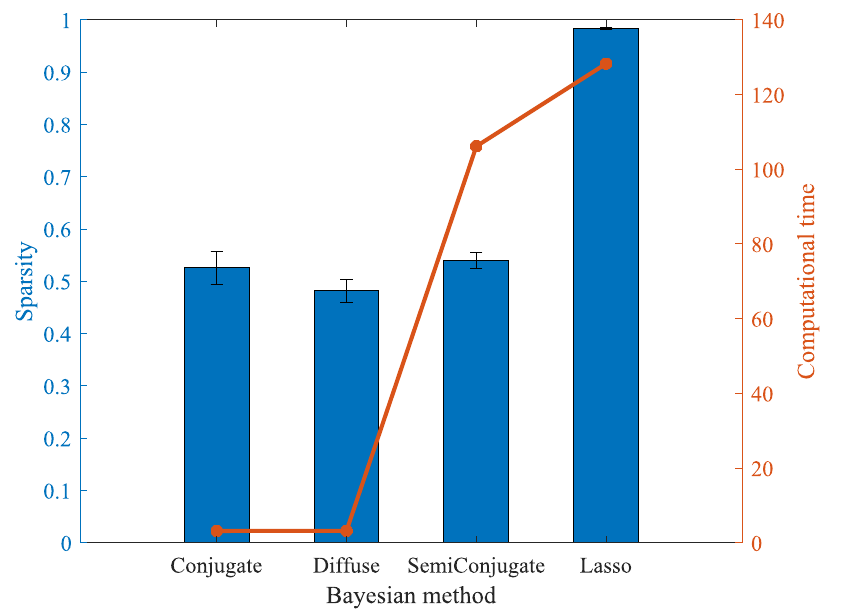
Fig 6. Computational time and sparsity of Bayesian Lasso method and other Bayesian